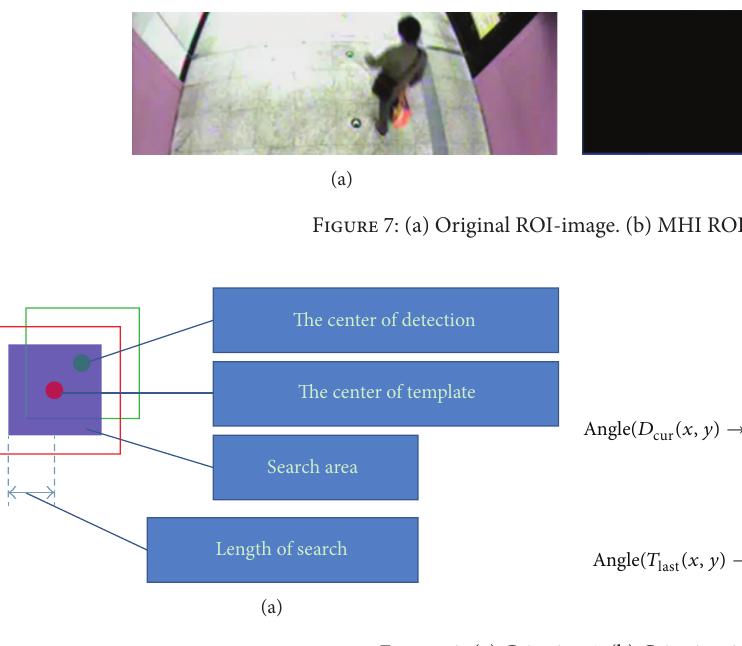
Figure 8: (a) Criterion 1. (b) Criterion